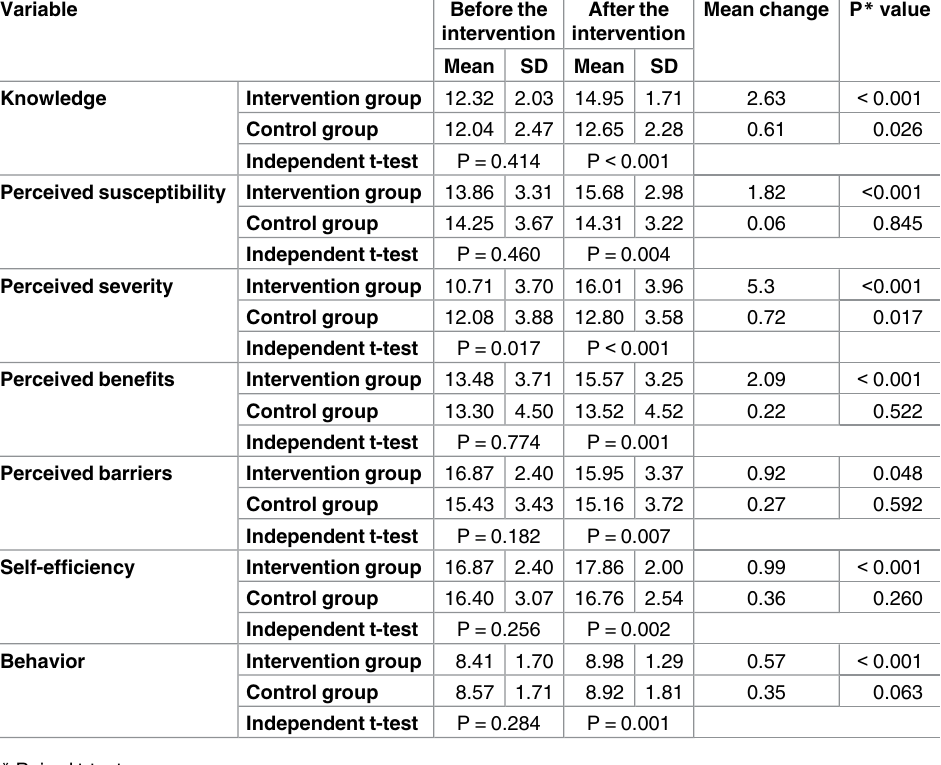
Pearson’s correlation coefficient showed that behaviors to prevent pediculosis were signifi- cantly correlated with perceived barriers (P < 0.001; r = 0.27) and self-efficiency (P = 0.018; Table 3. The participants’ mean scores of knowledge, constructs of the Health Belief Model, and behaviors to prevent pediculosis.